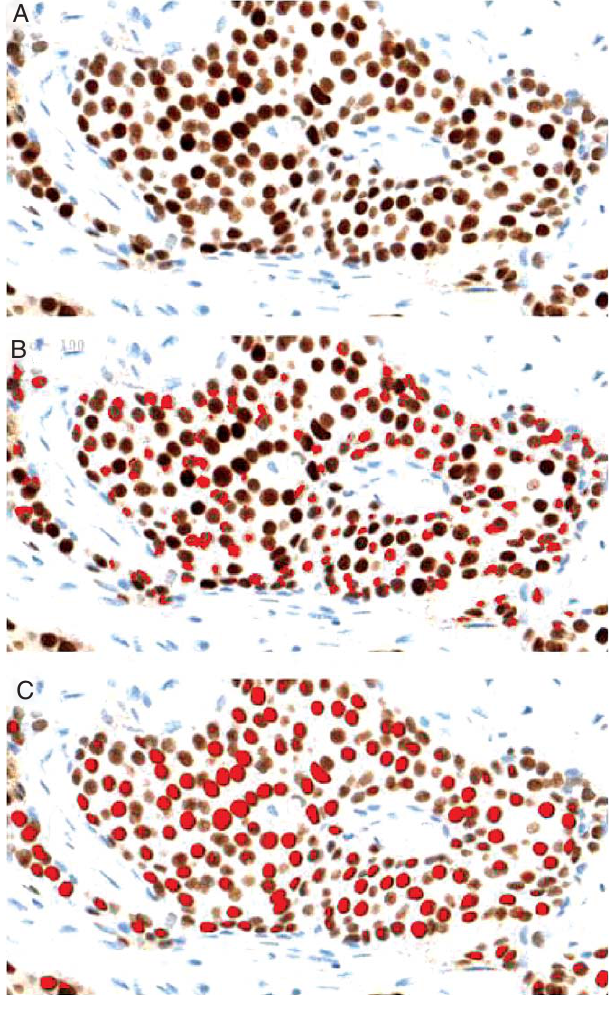
Fig. 7. Breast biopsy with ER staining. A breast core biopsy was stained with ER and scanned into a WSI (Panel A). Ring vectors were selected from lighter stained cells (Panel B) and darker stained cells (C). The dark staining had an area of 0.00255mm 2 and the lighter staining had an area of 0.00137mm 2